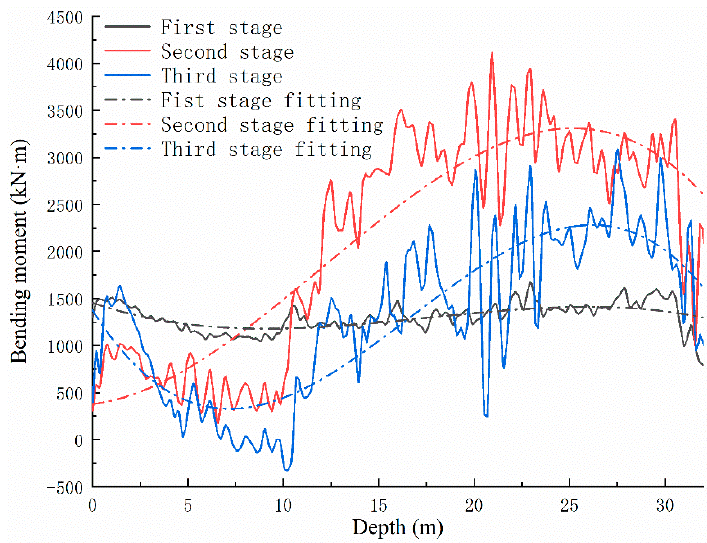
Figure 13. Graph of bending moment fitting of the anti-slide pile at different stages.